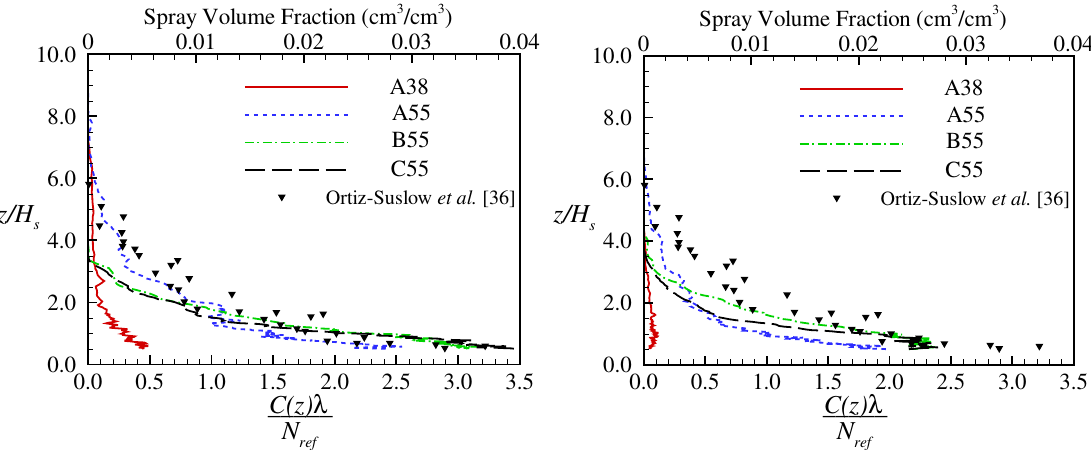
Figure 11. Instantaneous vertical profile of the concentration of sea spray droplets of ( a ) r = 100 µm and ( b ) r = 400 µm at the late stage of wave plunging ( t = 3.0 T ). The integral volume fraction of sea spray droplets of all scales at U 10 = 36 m/s obtained from the laboratory experiment of Ortiz-Suslow et al. [36] is superposed in the figure for comparison. The lower horizontal axis gives the scale of C ( z ) λ / N ref of our simulation. The upper horizontal axis gives the scale of the integral spray volume fraction of Ortiz-Suslow et al.